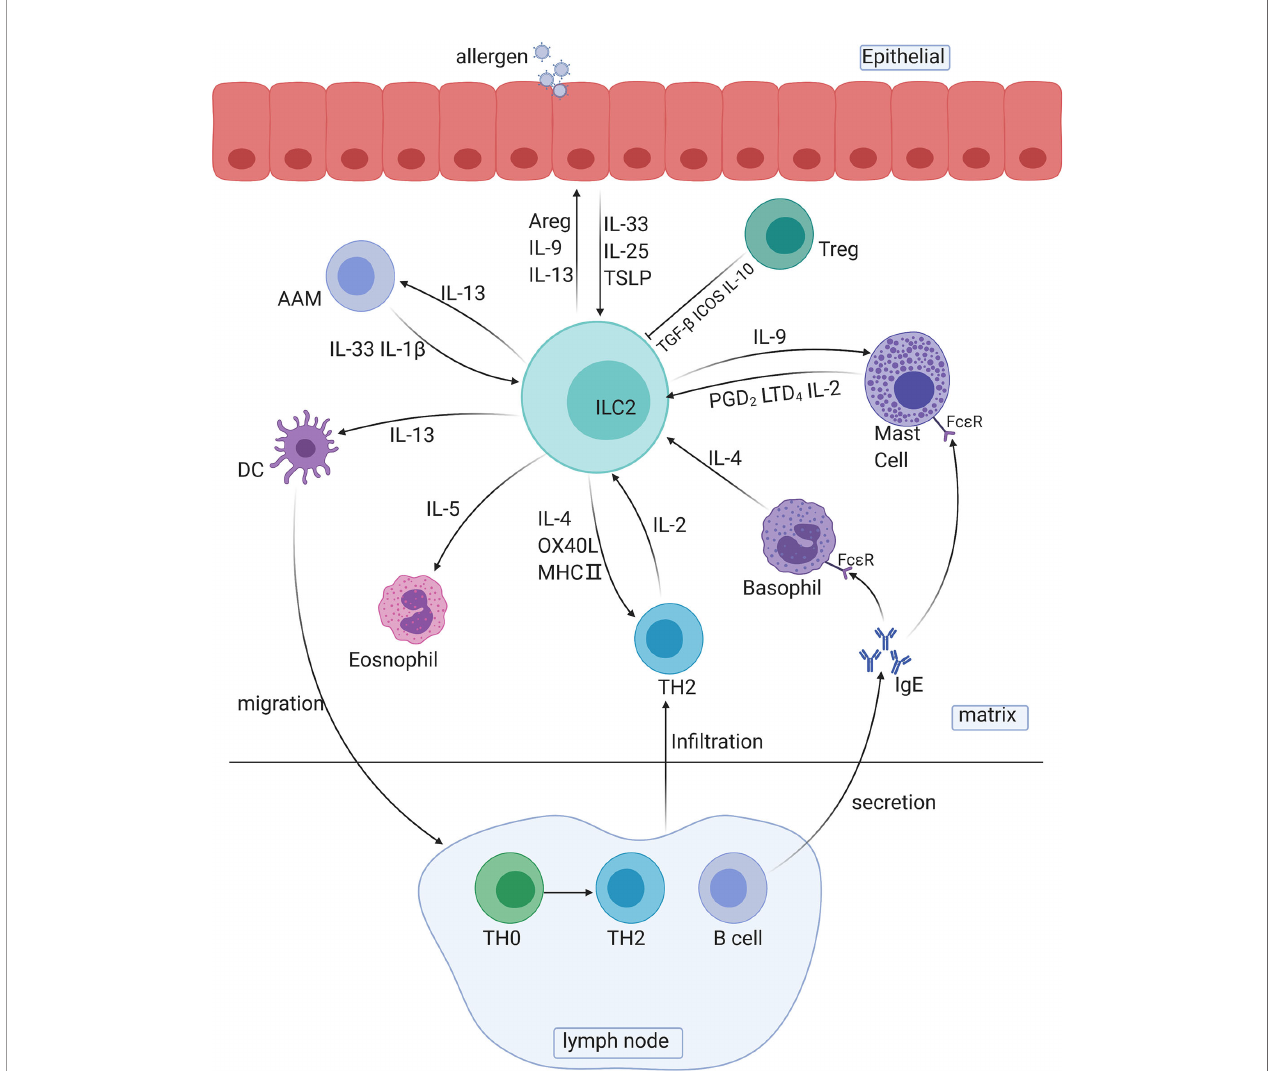
FIGURE 2 | The roles of ILC2s in immune responses. AAM, alternative activated macrophage; DC, dendritic cell; TH cells, T helper cells; Areg,